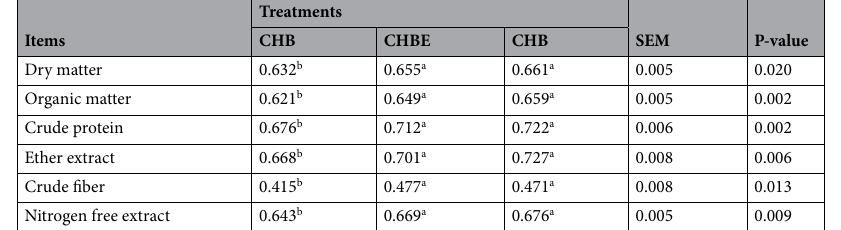
Table 5. Effects of hydroponic barley with or without enzymes on the nutrient digestibility coefficient of growing rabbits. SEM: Standard error of the means (n = 20); CHB: Control diet substituted with 25% hydroponic barley; CHBE: Control diet substituted with 25% hydroponic barley with 0.5 g/kg enzymes. a,b Means within the same row bearing different superscripts differ significantly (P < 0.05).